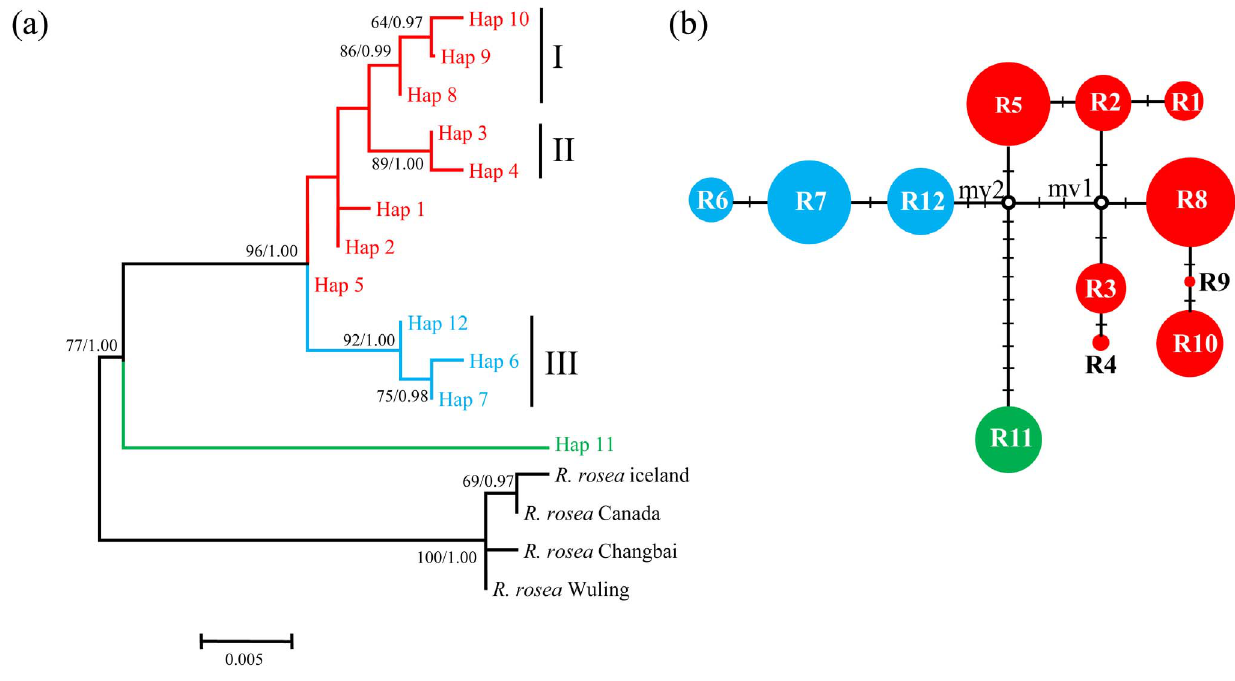
Figure 3. Phylogenetic relationships obtained by analysis of ITS ribotypes. (a) Bayesian tree with numbers above the branches indicating bootstrap values greater than 50% for MP analysis and Bayesian posterior probabilities. (b) NETWORK-derived genealogical relationship. The sizes of the circles in the network are proportional to the observed frequencies of the ribotypes. The small black bars represent mutation steps and the red dots represent missing ribotypes. For both subfigures, different colors represent different geographic origins of ribotypes: red, the Qinghai-Tibetan Plateau and Hengduan Mountains; blue, northern China; green, central Asia.